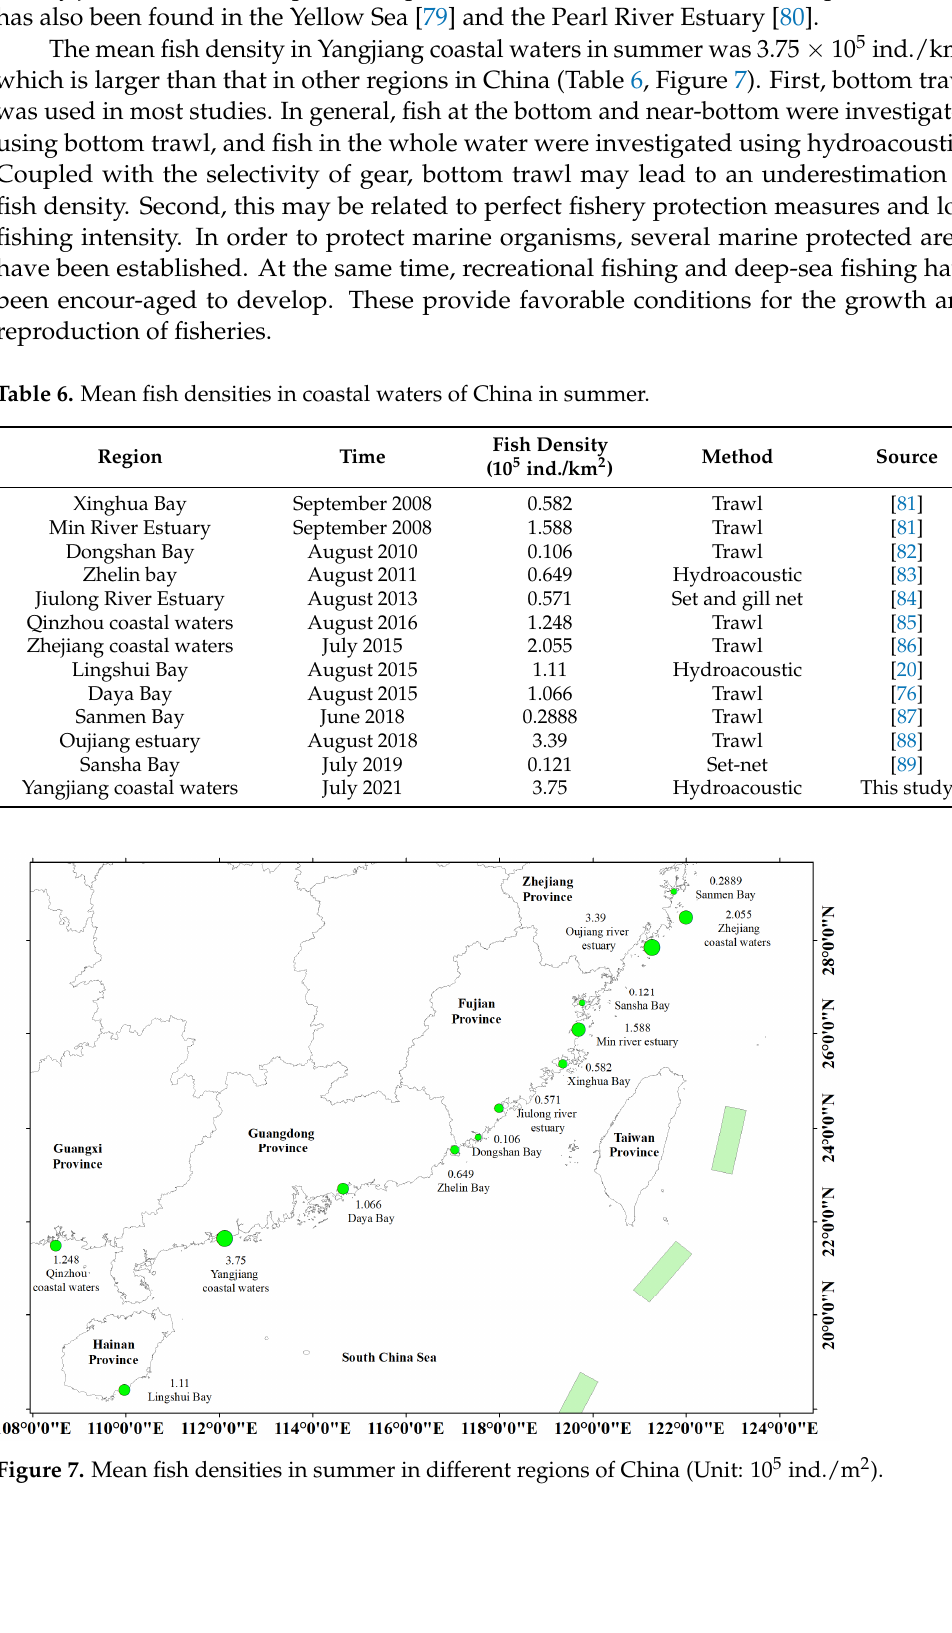
Figure 7. Mean fish densities in summer in different regions of China (Unit: 10 5 ind./m 2 ).